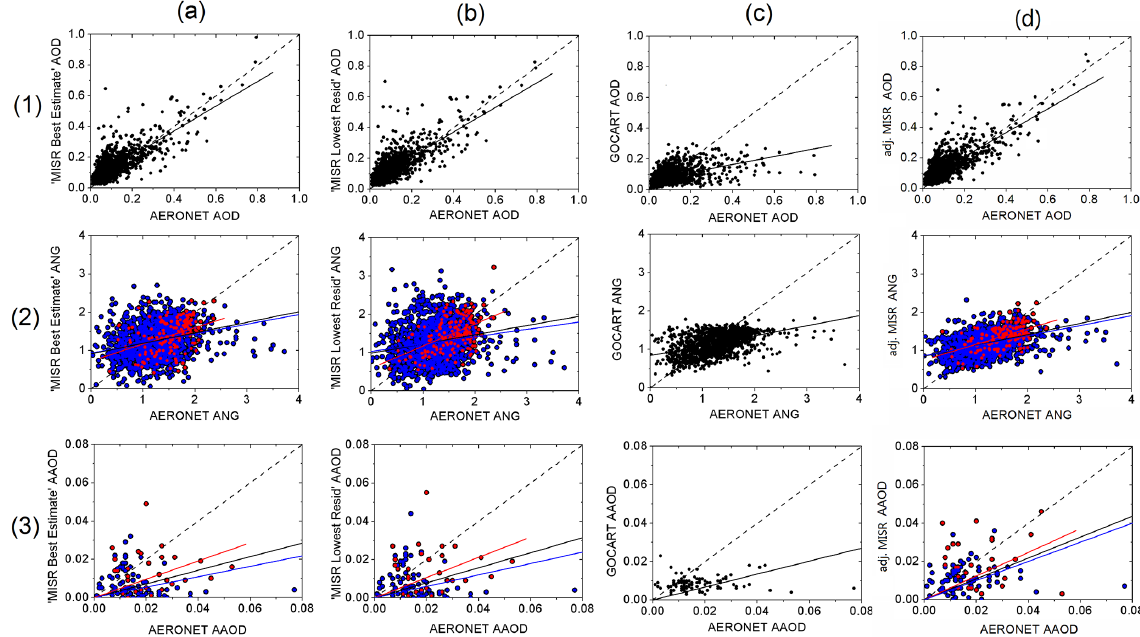
Figure 3. Validation of “MISR Best Estimate” (a) , “MISR Lowest Resid” (b) , GOCART (c) , and AOD from this study (d) ; AOD along row 1, ANG along row 2, and AAOD along row 3, by comparison with AERONET observations. The black (for rows 2 and 3, over-plotted with blue and red points), blue, and red points represent all AOD, AOD ≤ 0.2, and AOD>0.2 conditions, respectively. For AAOD, blue and red points are divided at AOD = 0.5 rather than 0.2. The black, blue, and red lines represent the corresponding regression lines. The dashed line is the y = x line. AERONET AAOD is only retrieved when the AOD at 440nm is greater than 0.4 and the solar zenith angle is larger than 50. Only 107 matched MISR–AERONET AAOD data records are found in our study